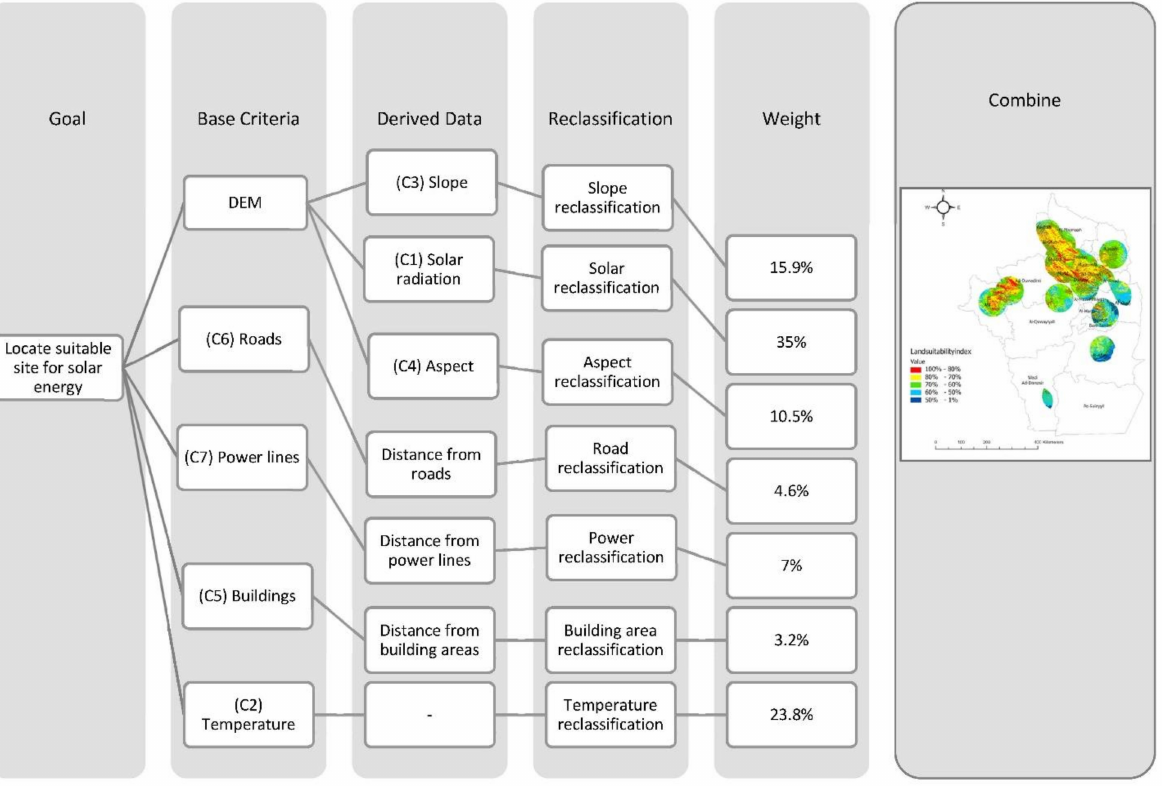
Figure 7. Process for identifying the preferred locations of solar energy projects in Riyadh. Seven factors were chosen as the decision criteria for producing a suitability